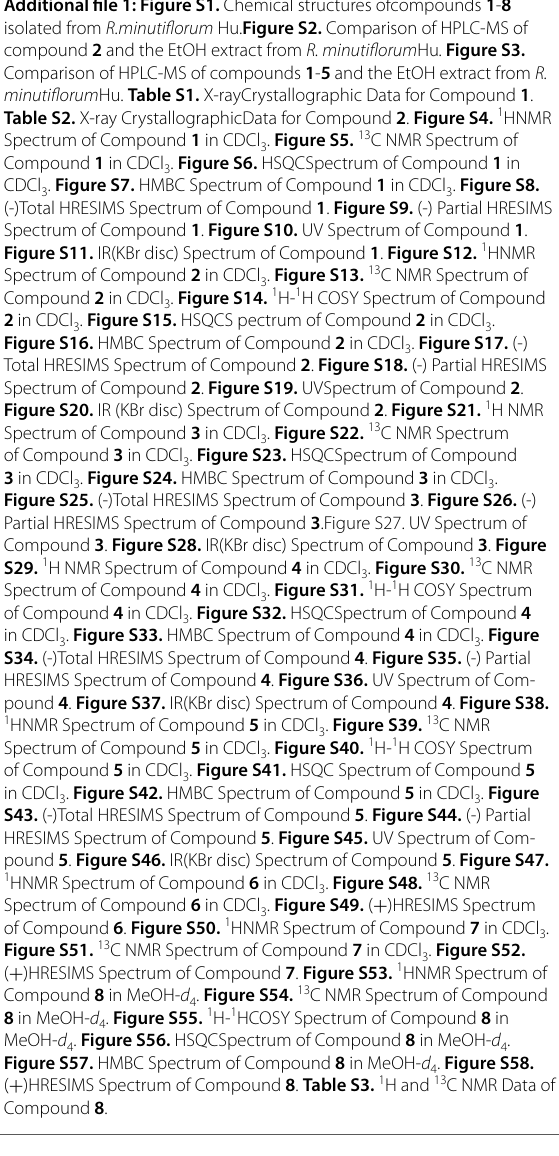
Spectrum of Compound 1 in CDCl 3 . Figure S5. 13 C NMR Spectrum of Compound 1 in CDCl 3 . Figure S6. HSQCSpectrum of Compound 1 in CDCl 3 . Figure S7. HMBC Spectrum of Compound 1 in CDCl 3 . Figure S8. (‑)Total HRESIMS Spectrum of Compound 1 . Figure S9. (‑) Partial HRESIMS Spectrum of Compound 1 . Figure S10. UV Spectrum of Compound 1 . Figure S11. IR(KBr disc) Spectrum of Compound 1 . Figure S12. 1 HNMR Spectrum of Compound 2 in CDCl 3 . Figure S13. 13 C NMR Spectrum of Compound 2 in CDCl 3 . Figure S14. 1 H‑ 1 H COSY Spectrum of Compound 2 in CDCl 3 . Figure S15. HSQCS pectrum of Compound 2 in CDCl 3 . Figure S16. HMBC Spectrum of Compound 2 in CDCl 3 . Figure S17. (‑) Total HRESIMS Spectrum of Compound 2 . Figure S18. (‑) Partial HRESIMS Spectrum of Compound 2 . Figure S19. UVSpectrum of Compound 2 . Figure S20. IR (KBr disc) Spectrum of Compound 2 . Figure S21. 1 H NMR Spectrum of Compound 3 in CDCl 3 . Figure S22. 13 C NMR Spectrum of Compound 3 in CDCl 3 . Figure S23. HSQCSpectrum of Compound 3 in CDCl 3 . Figure S24. HMBC Spectrum of Compound 3 in CDCl 3 . Figure S25. (‑)Total HRESIMS Spectrum of Compound 3 . Figure S26. (‑) Partial HRESIMS Spectrum of Compound 3 .Figure S27. UV Spectrum of Compound 3 . Figure S28. IR(KBr disc) Spectrum of Compound 3 . Figure S29. 1 H NMR Spectrum of Compound 4 in CDCl 3 . Figure S30. 13 C NMR Spectrum of Compound 4 in CDCl 3 . Figure S31. 1 H‑ 1 H COSY Spectrum of Compound 4 in CDCl 3 . Figure S32. HSQCSpectrum of Compound 4 in CDCl 3 . Figure S33. HMBC Spectrum of Compound 4 in CDCl 3 . Figure S34. (‑)Total HRESIMS Spectrum of Compound 4 . Figure S35. (‑) Partial HRESIMS Spectrum of Compound 4 . Figure S36. UV Spectrum of Com‑ pound 4 . Figure S37. IR(KBr disc) Spectrum of Compound 4 . Figure S38. 1 HNMR Spectrum of Compound 5 in CDCl 13 C NMR 3 . Figure S39. Spectrum of Compound 5 in CDCl 3 . Figure S40. 1 H‑ 1 H COSY Spectrum of Compound 5 in CDCl 3 . Figure S41. HSQC Spectrum of Compound 5 in CDCl 3 . Figure S42. HMBC Spectrum of Compound 5 in CDCl 3 . Figure S43. (‑)Total HRESIMS Spectrum of Compound 5 . Figure S44. (‑) Partial HRESIMS Spectrum of Compound 5 . Figure S45. UV Spectrum of Com‑ pound 5 . Figure S46. IR(KBr disc) Spectrum of Compound 5 . Figure S47. 1 HNMR Spectrum of Compound 6 in CDCl 13 C NMR 3 . Figure S48. Spectrum of Compound 6 in CDCl 3 . Figure S49. ( )HRESIMS Spectrum + of Compound 6 . Figure S50. 1 HNMR Spectrum of Compound 7 in CDCl 3 . Figure S51. 13 C NMR Spectrum of Compound 7 in CDCl 3 . Figure S52. ( )HRESIMS Spectrum of Compound 7 . Figure S53. 1 HNMR Spectrum of + Compound 8 in MeOH‑ d 4 . Figure S54. 13 C NMR Spectrum of Compound 8 in MeOH‑ d 4 . Figure S55. 1 H‑ 1 HCOSY Spectrum of Compound 8 in MeOH‑ d 4 . Figure S56. HSQCSpectrum of Compound 8 in MeOH‑ d 4 . Figure S57. HMBC Spectrum of Compound 8 in MeOH‑ d 4 . Figure S58. ( )HRESIMS Spectrum of Compound 8 . Table S3. 1 H and 13 C NMR Data of + Compound 8